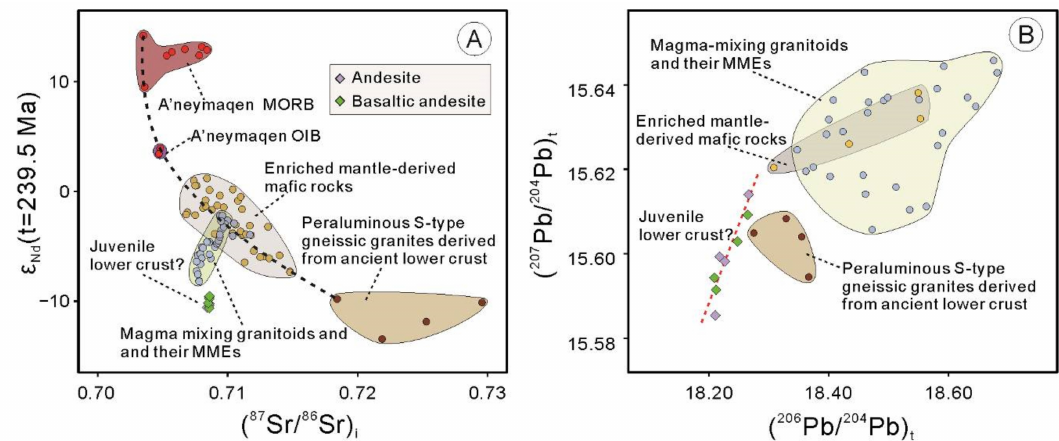
Figure 7. Plots of ( A ) ( 87 Sr/ 86 Sr) i vs. ε Nd (t) and ( B ) ( 207 Pb/ 204 Pb) t vs. ( 206 Pb/ 204 Pb) t . Data source: A’nyemaqen MORB and OIB (interpreted Paleo-Tethyan evolution related) are from Refs. [49,50]); Peraluminous S-type gneissic granites from Ref. [51]; Magma-mixing granitoids and their MMEs from Refs. [23,26,52]; Enriched Mantle-derived Mafic rocks from Refs.